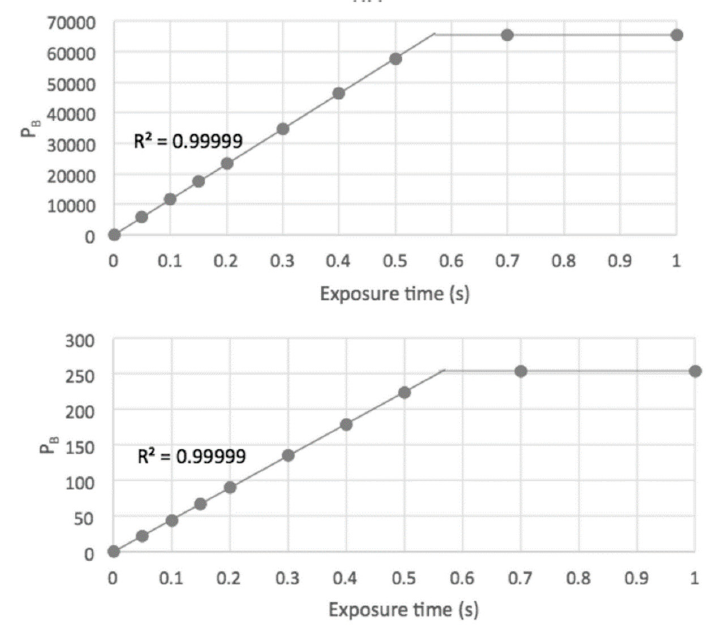
Figure 10. Blue-pixel grey-scale values of the 16-bit TIFF (upper) and 8-bit “JPEG” (lower) image files of an area of a fluorescent DPA solution as a function of the camera exposure time setting.